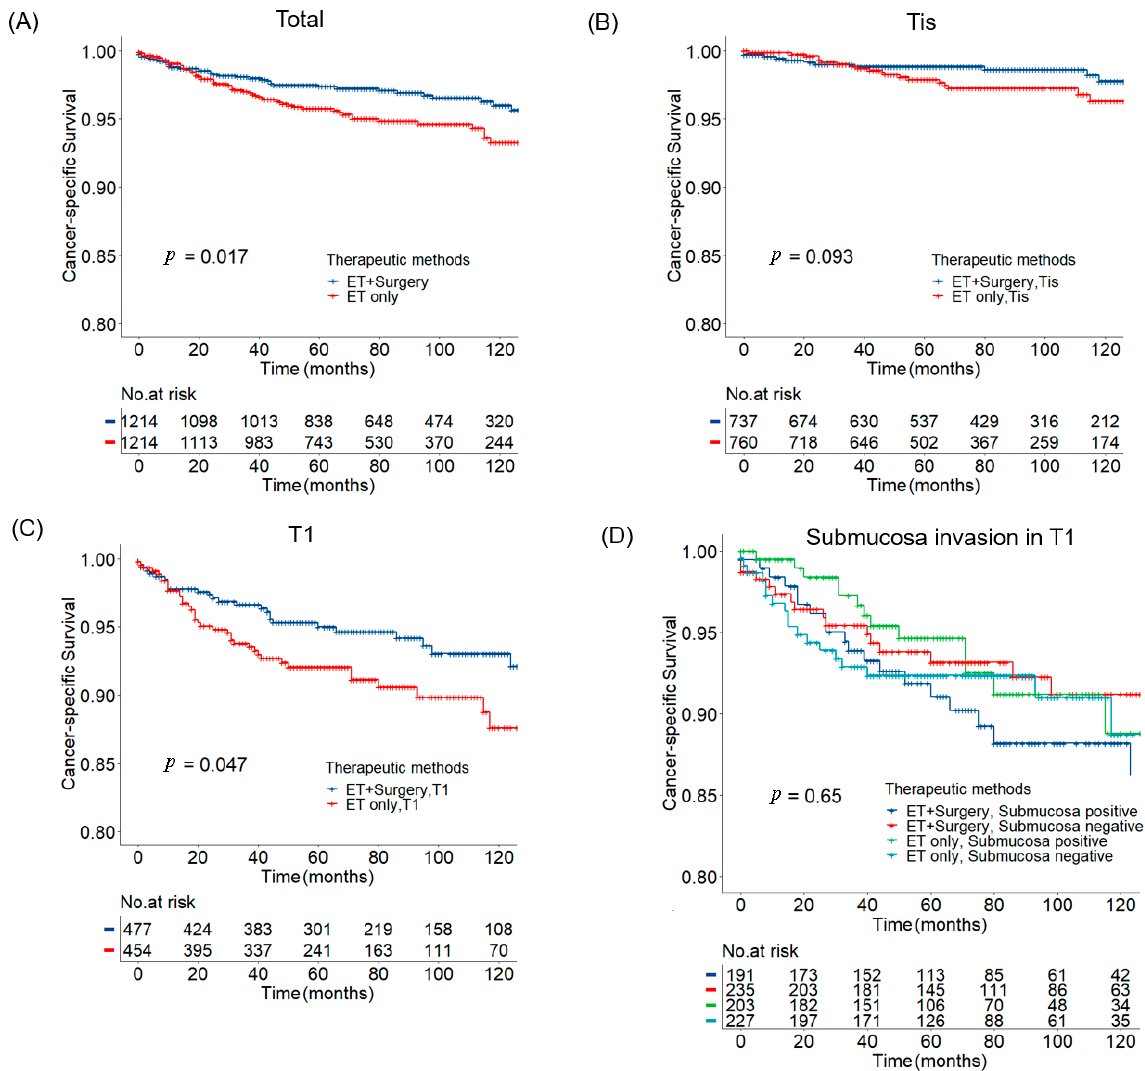
Figure 2. Kaplan–Meier cancer-specific survival plots in patients who underwent endoscopic removal of invasive neoplasia. ( A ) All patients; ( B ) patients with intramucosal carcinoma (Tis); ( C ) patients with submucosal carcinoma (T1); ( D ) patients with or without submucosa invasion.